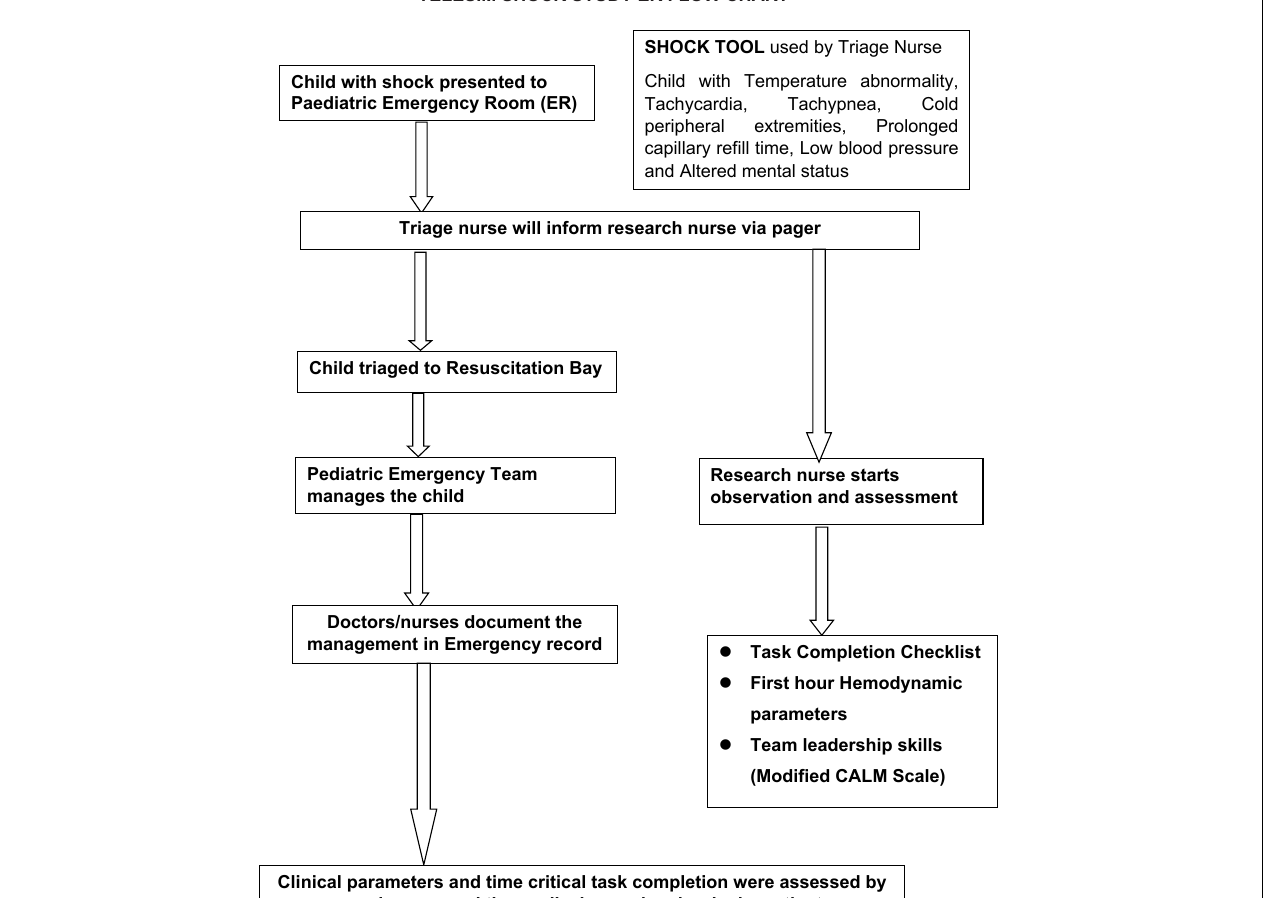
FIGURE 5 | Algorithm depicting the flow of the telesimulation study in the emergency room.